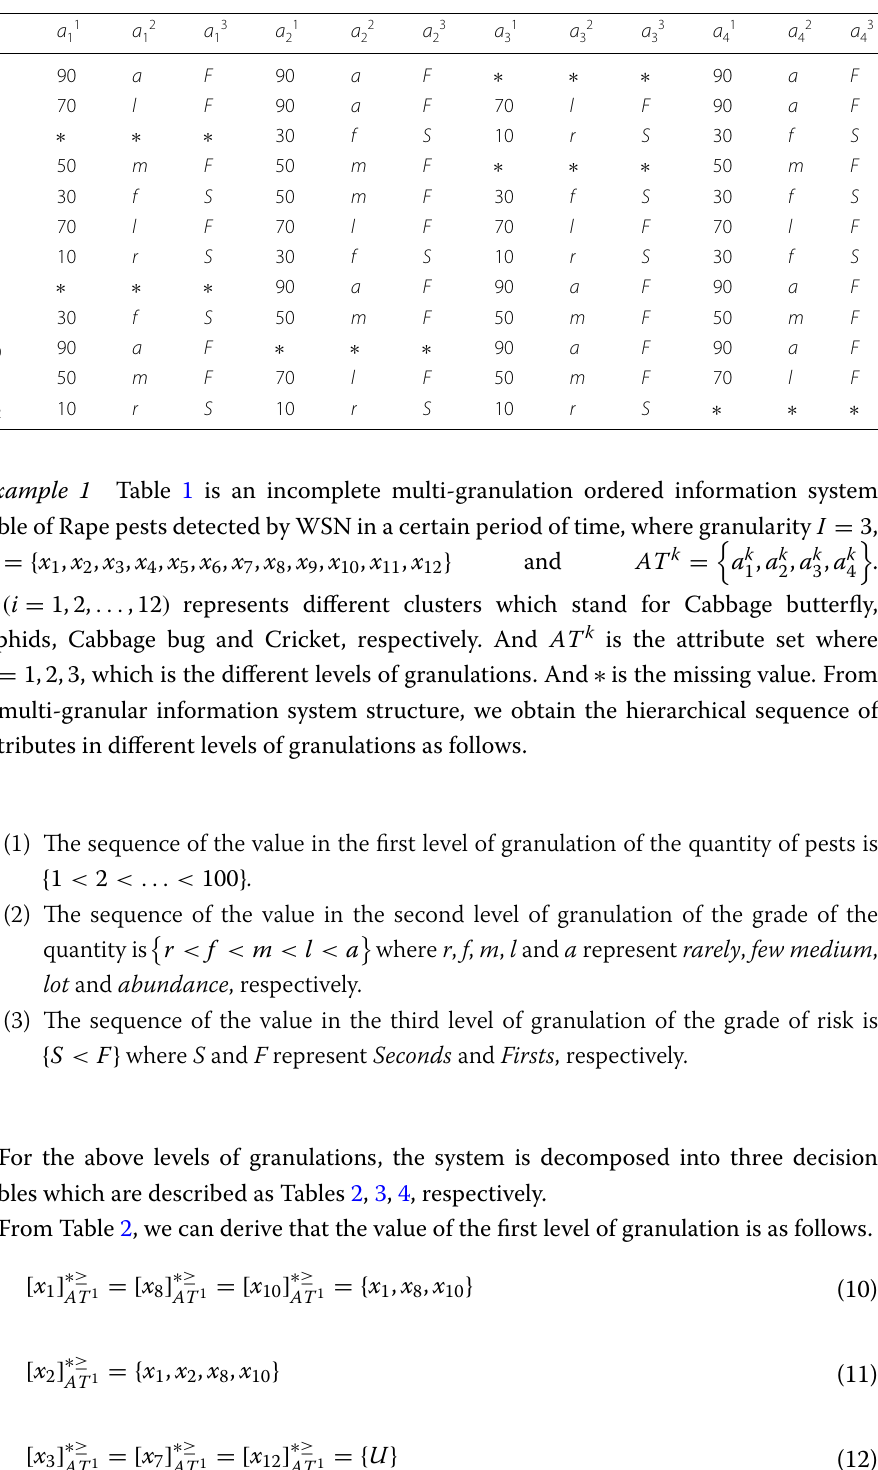
Table 1 A multi-granulation incomplete ordered information system with three levels of